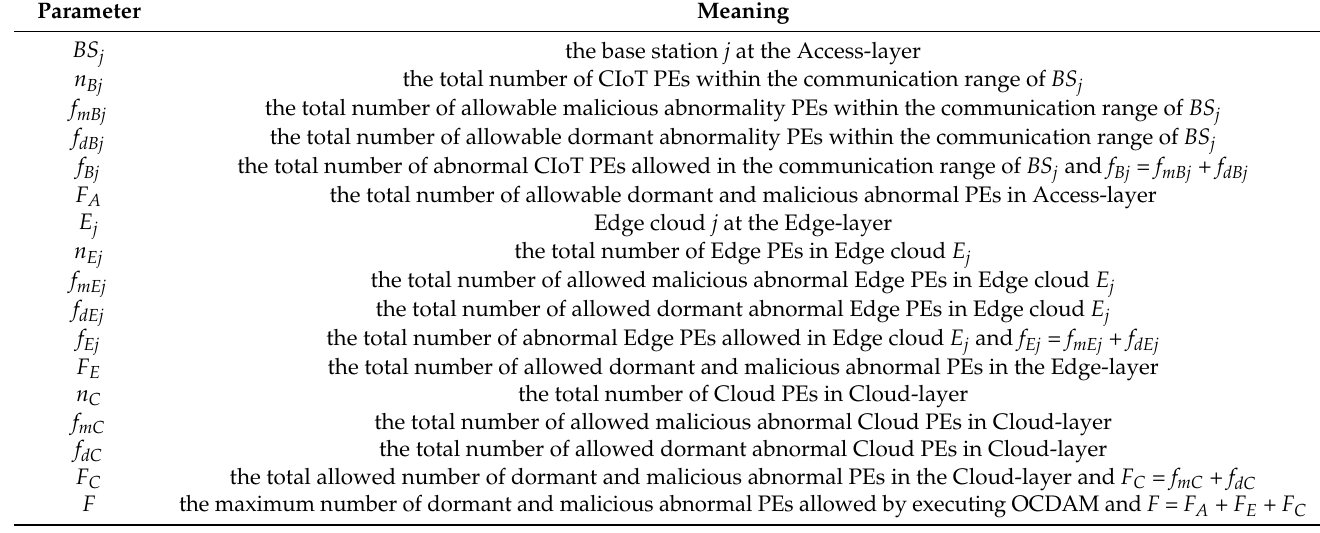
Table 3. The parameters used in optimization